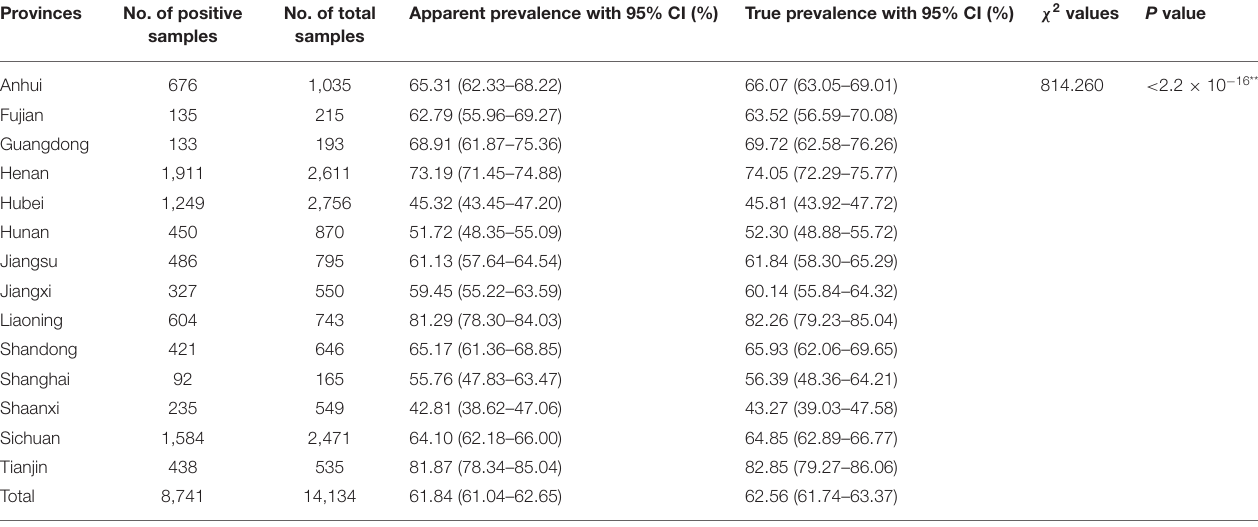
TABLE 1 | The apparent and true prevalence of PRRSV antibody with Pearson chi-square test in 12 provinces and two cities in China. Provinces